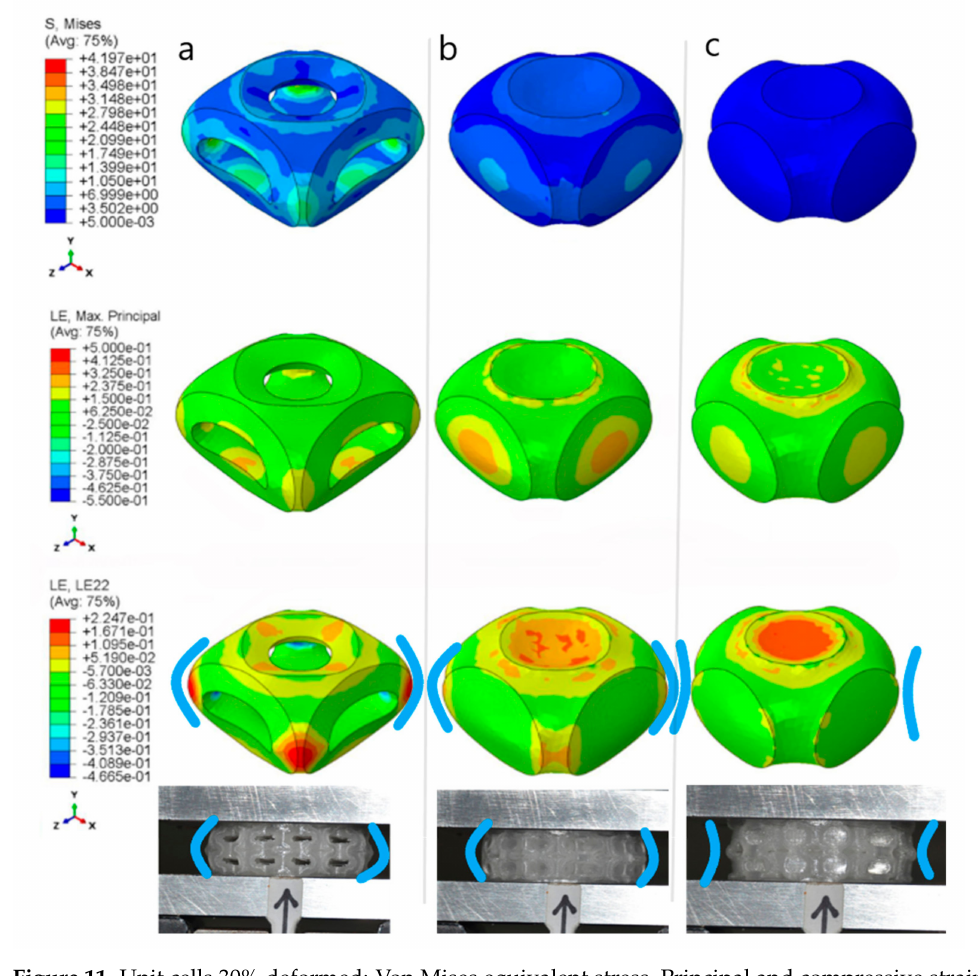
Figure 11. Unit cells 30% deformed: Von Mises equivalent stress, Principal and compressive strains ε 22 . The deformation behaviour of open ( a ), thin ( b ) shows barrelling, whereas thick wall ( c ) negative barrelling effect is